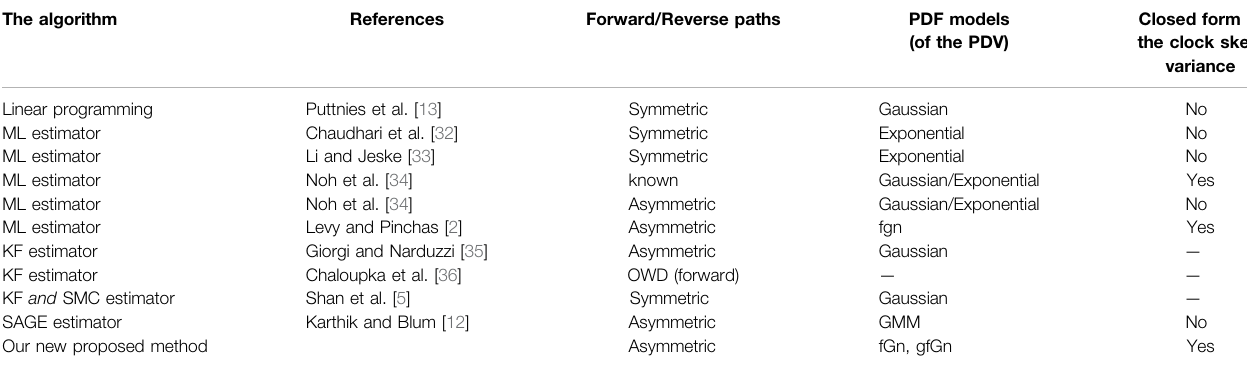
TABLE 1 | Clock skew